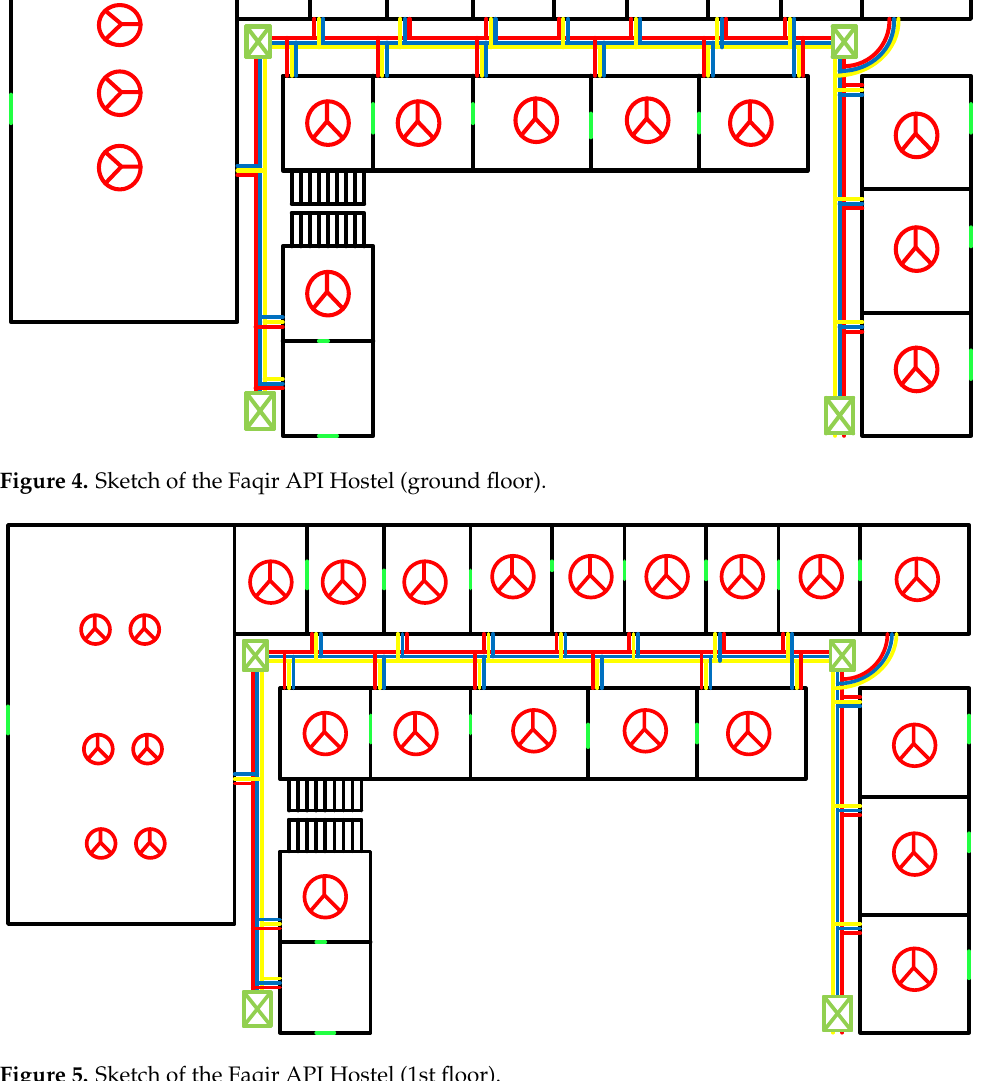
Figure 5. Sketch of the Faqir API Hostel (1st